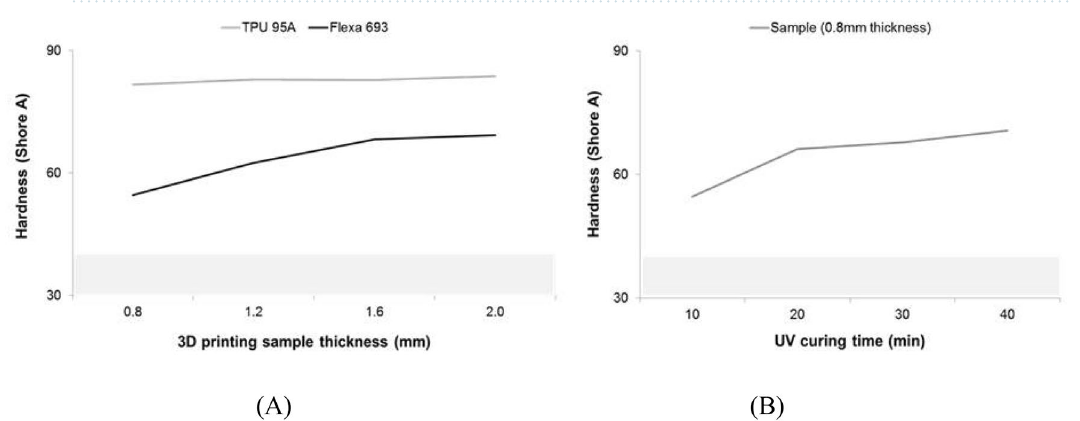
Figure 3. Comparison of mechanical properties of 3D printing materials. The gray zone in both graphs is human cardiac tissue to shore A hardness (mean) of about 40. ( A ) Hardness with different thickness values of two FDM printing materials. ( B ) Hardness according to UV curing time of one material. 3D three-dimensional, FDM fused deposition modeling, UV